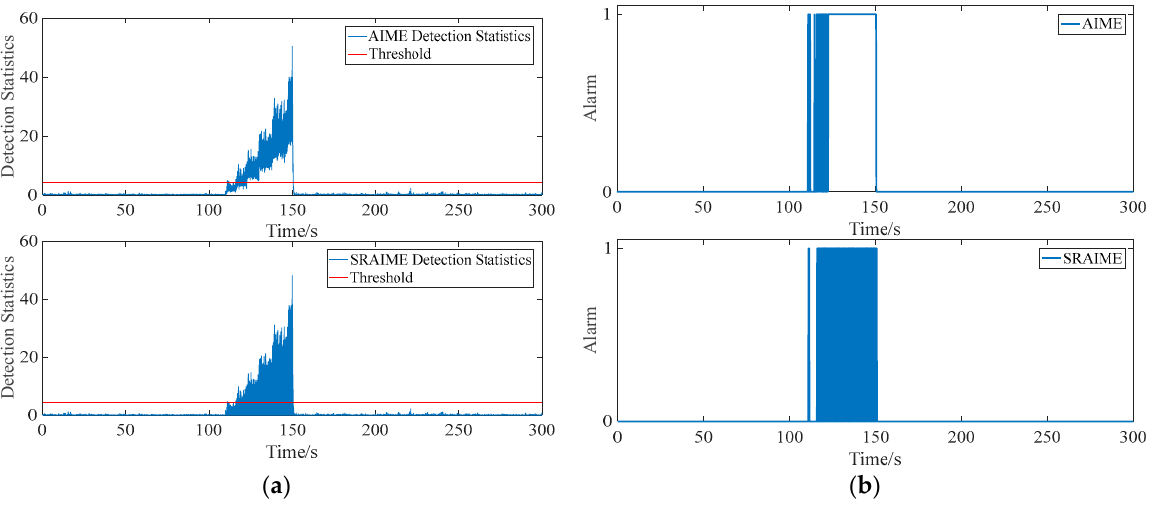
Figure 7. The slowly-growing gross error detection result of Suntuan River Bridge by GNSS/accelerometer fusion after adding gross errors: ( a ) Detection statistics after adding gross errors; ( b ) Alert situation after adding gross errors. Table 1. Suntuan River Bridge statistics of AIME/SRAIME gross error detection results.